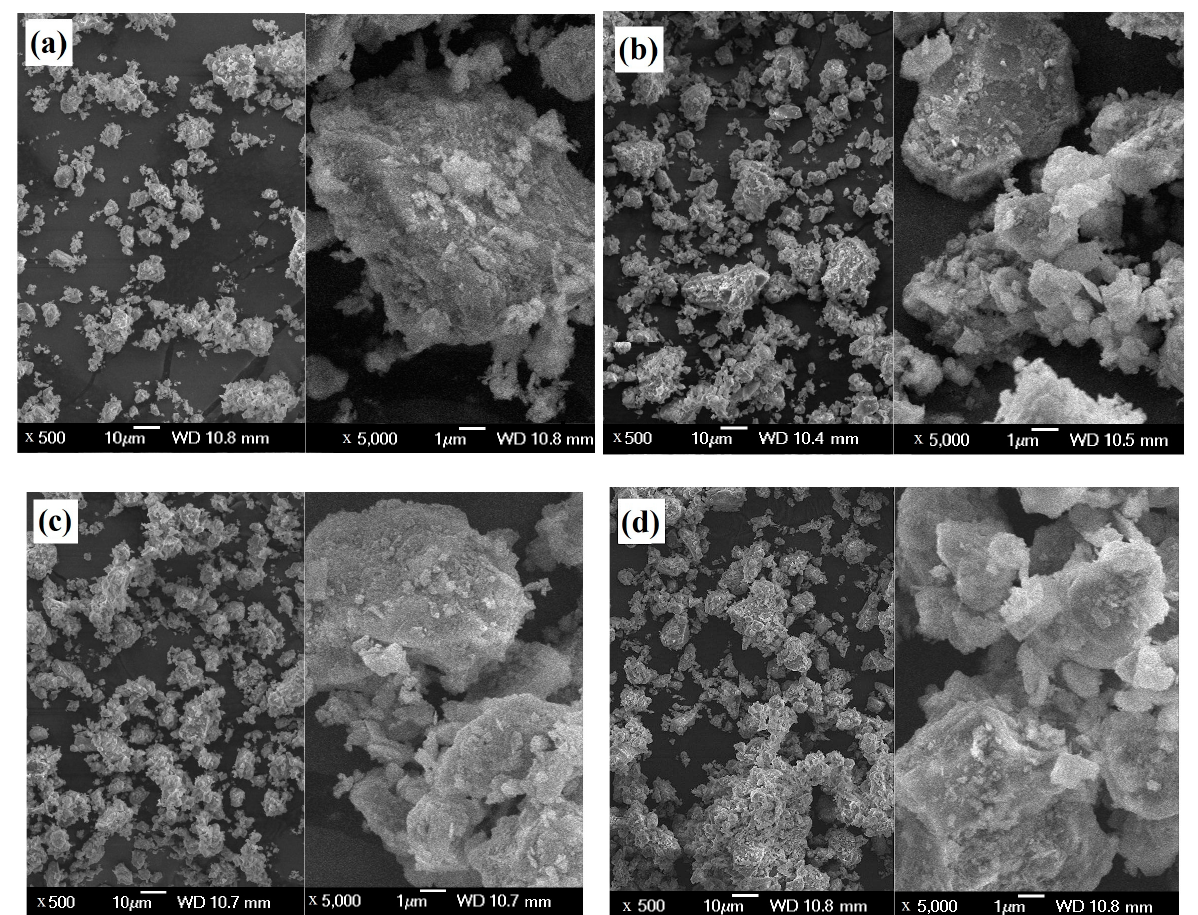
Figure 4. Morphology of TTCPM ( a ), 1 Mg TTCPM850 ( b ), 1 Mg TTCPM1000 ( c ), and 2 Mg TTCPM1000 ( d ) starting powder cement mixtures.